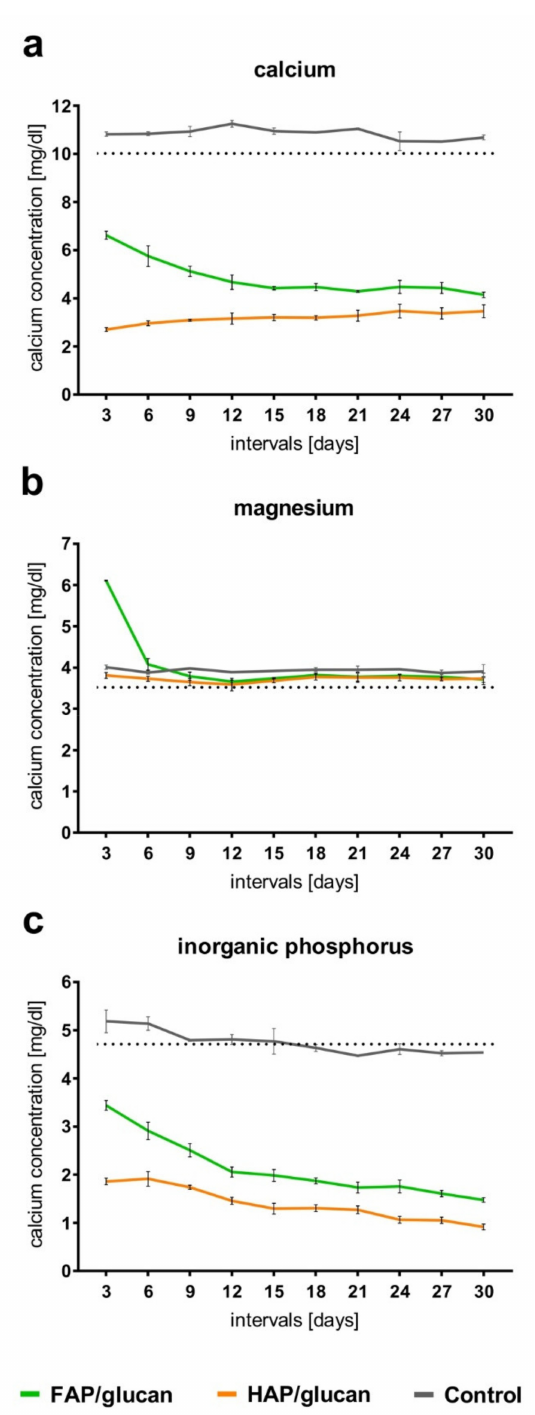
Figure 6. Calcium ( a ), magnesium ( b ), and phosphorus ( c ) ion changes in SBF by investigated materials. Dotted line indicates ion concentration in freshly made